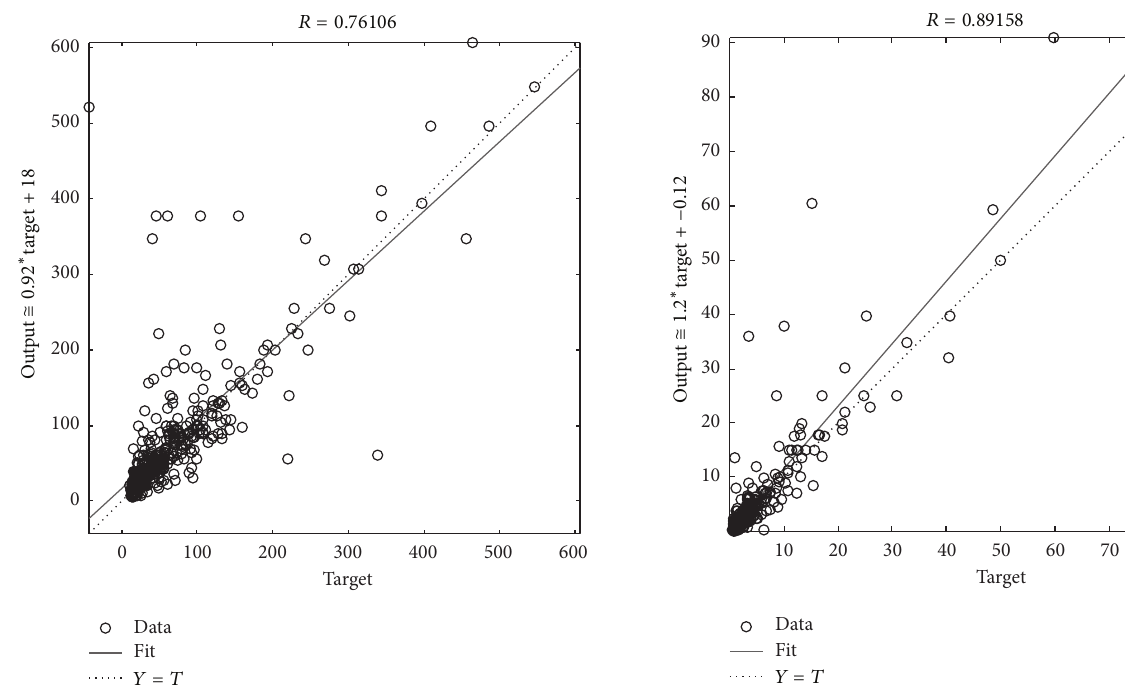
Figure 15: Zinc expression using logarithmic